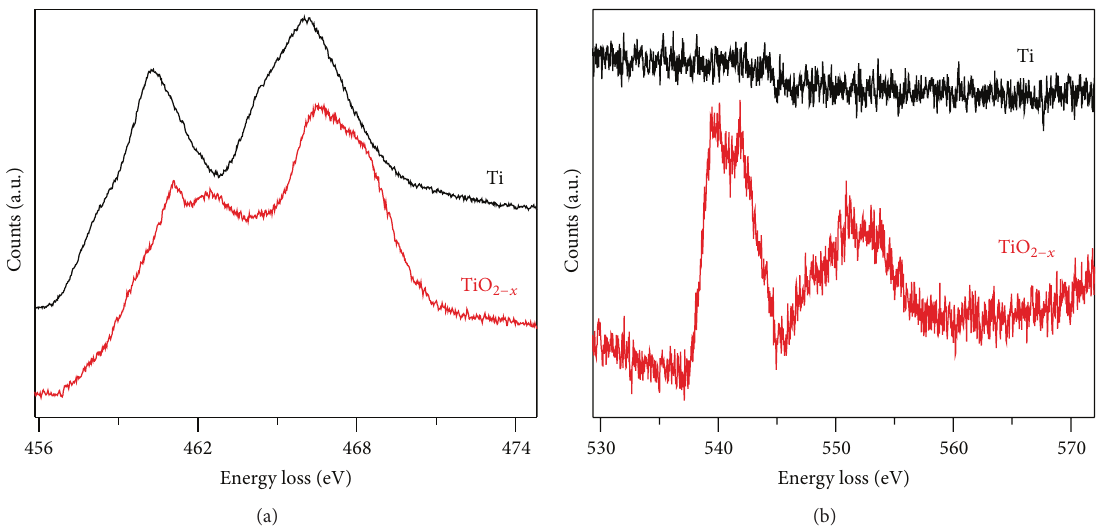
Figure 3: (Color online) EELS spectra of Ti (black lines) and Ti oxide (red lines) for (a) Ti L 2;3 core-loss and (b) O K core-loss.